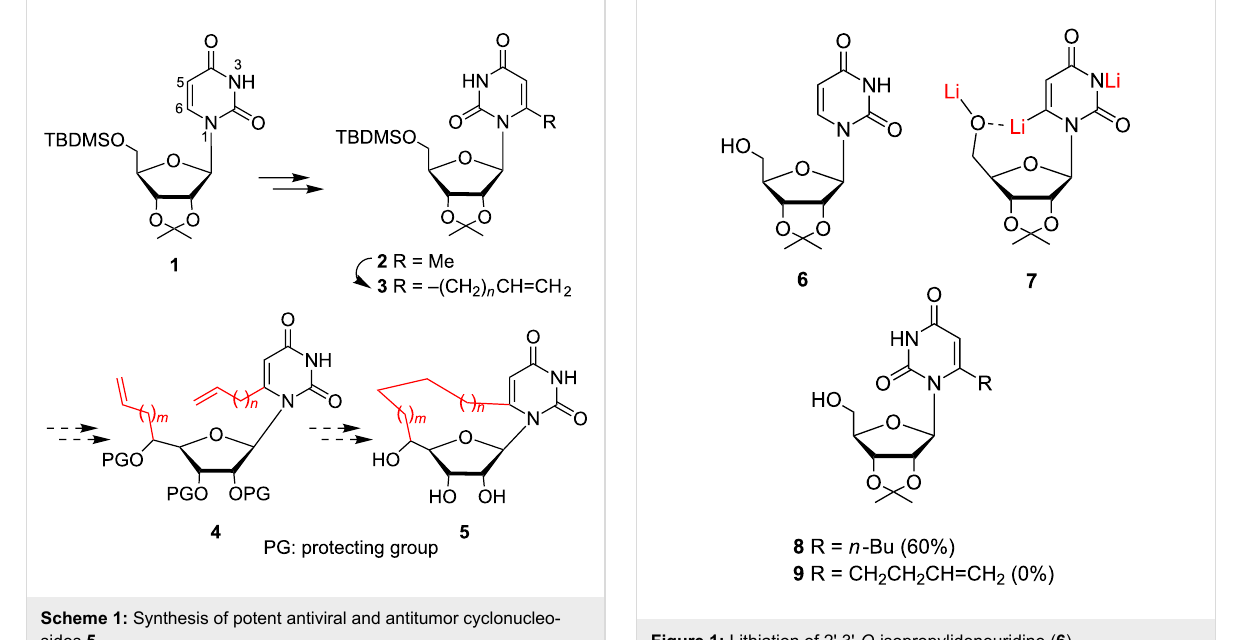
Figure 1: Lithiation of 2',3'- O -isopropylideneuridine ( 6 ).